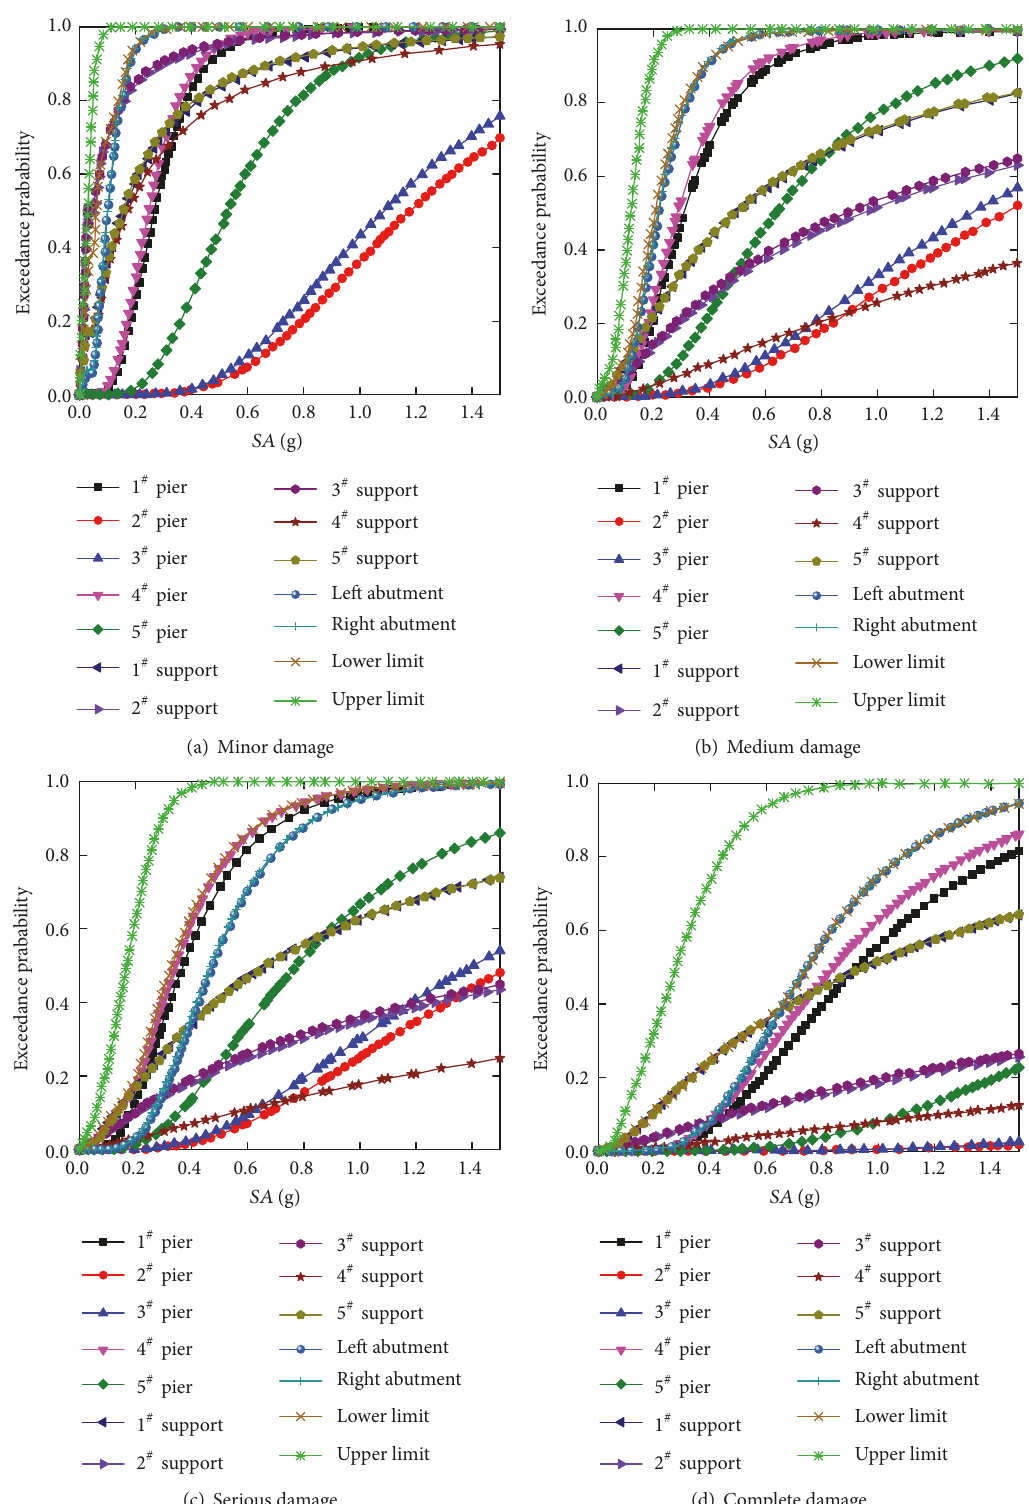
Figure 23: The fragility curves of bridge system and all components under different